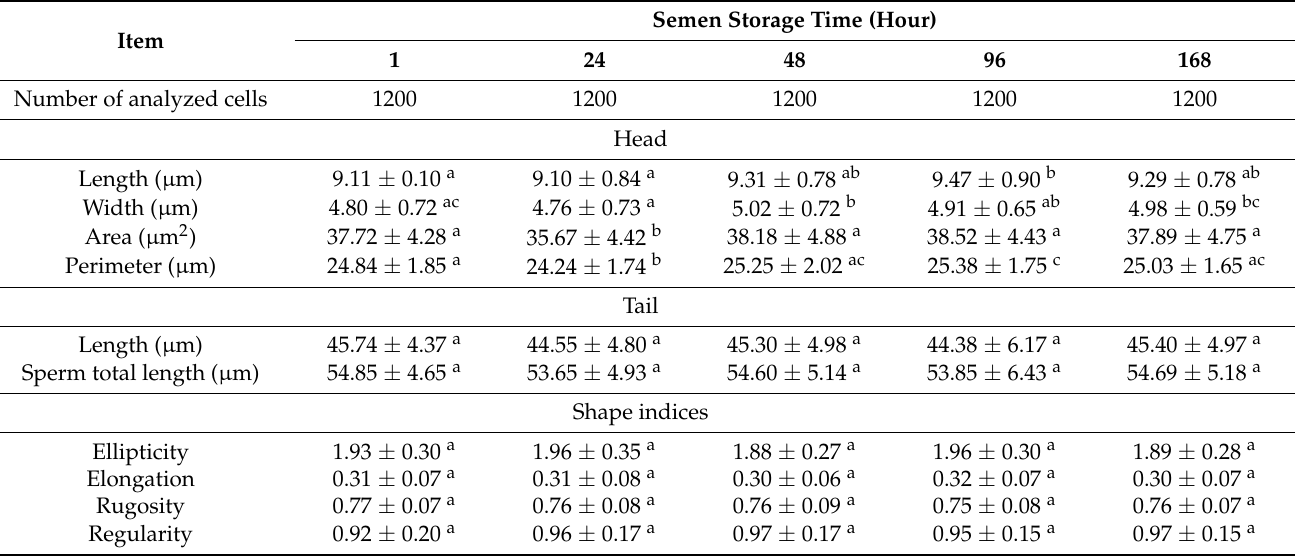
Table 3. Morphometric dimensions of sperm stained by the SpermBlue method in semen stored at 17 ◦ C (mean ±